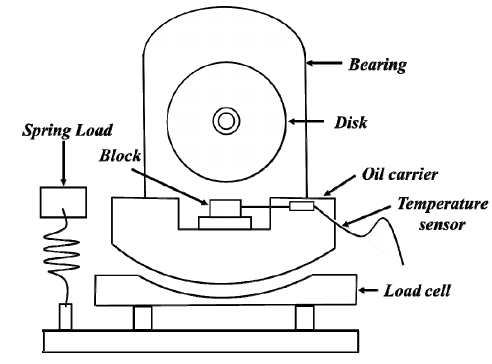
Figure 2. Schematic view of running-in test apparatus